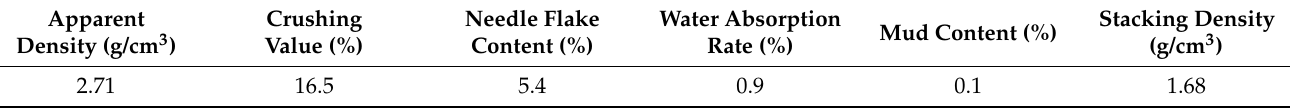
Table 2. Basic properties of the coarse aggregates of common gravel used in the test.